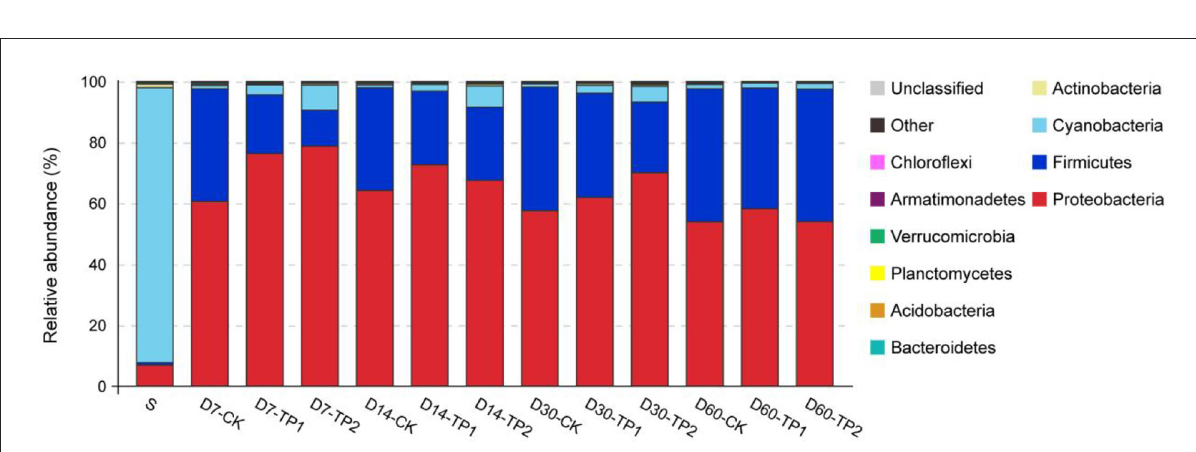
FIGURE2 Relative abundance of bacterial community on phylum level of stylo silage ensiled with addition of tea polyphenols (S: raw stylo; D7-CK: on day 7 of ensiling fermentation-blank control, silage ensiled without addition of tea polyphenols; TP1 and TP2: silage ensiled with addition of 0.2%, 0.4% tea polyphenols on a FM